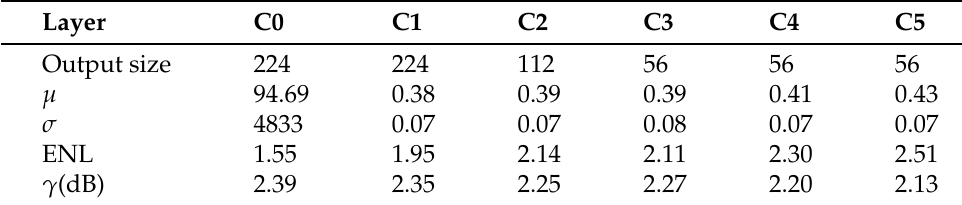
Table 5. Evaluation of different output feature layers. Layer